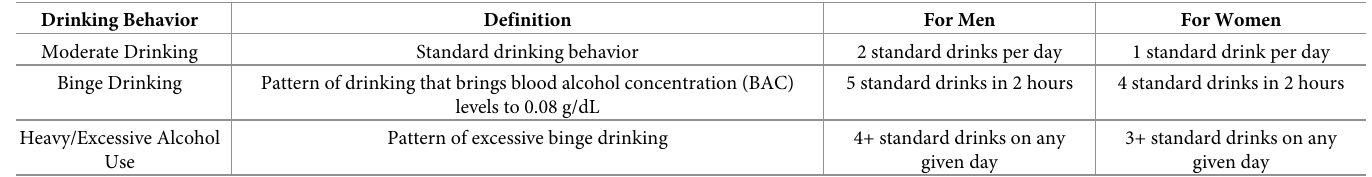
Table 1. Standard drinking behaviors as recommended by the National Institute on Alcohol Abuse and Alcoholism (NIAAA) [1]. Drinking